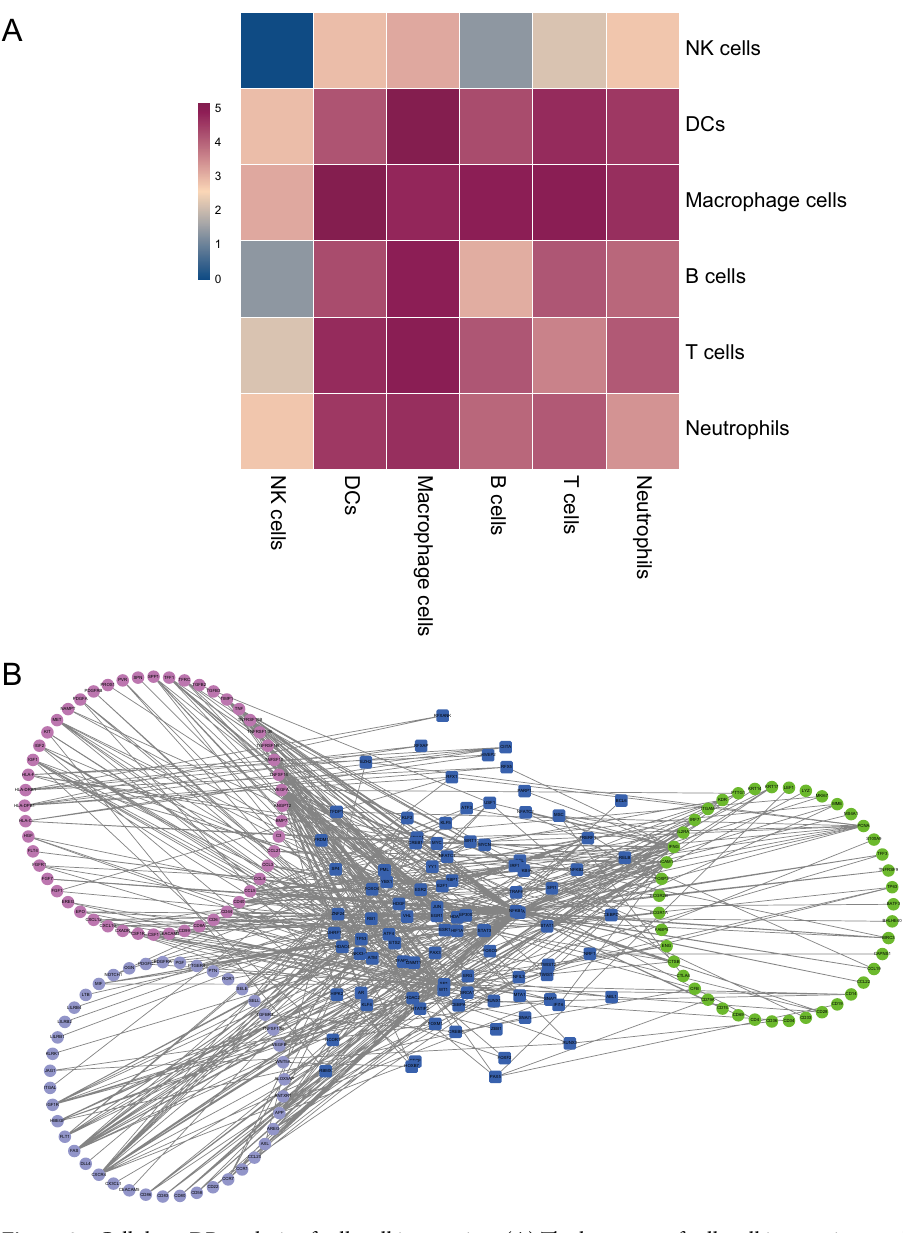
Figure 3. CellphoneDB analysis of cell–cell interaction. ( A ) The heat map of cell–cell interaction on the strength of the ligand-receptor. ( B ) The multi-factor interaction network of ligand-receptor in combination with the transcription factor (Blue represents the transcription factor TF; green denotes the immune marker gene; red represents the ligand gene ligand, and light blue represents the receptor gene